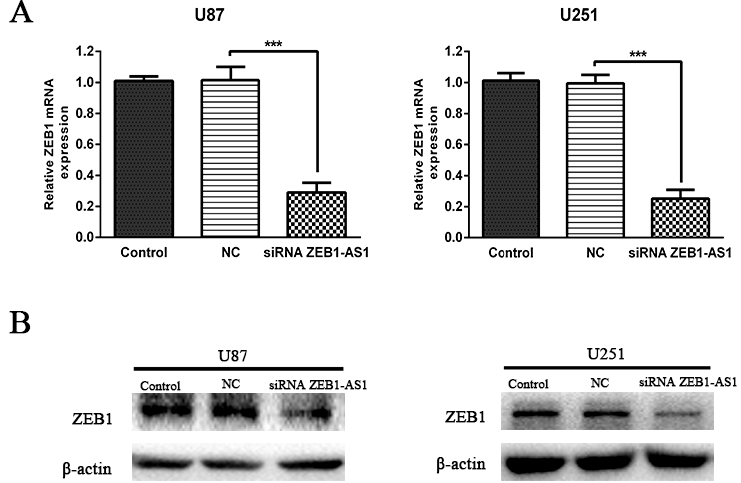
Figure 5. Knockdown of lncRNA ZEB1-AS1 decreased the expression of ZEB1. ( A , B ) Levels of ZEB1 mRNA and protein were detected by qRT-PCR and western blot after ZEB1-AS1 knockdown in U87 and U251 cell lines. *** p < 0.001.